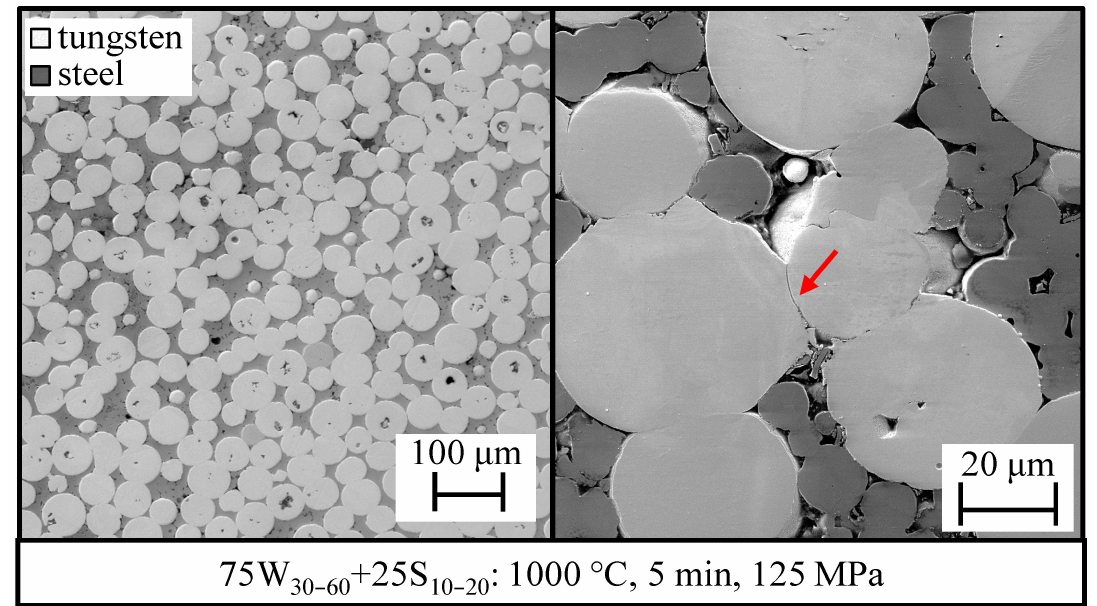
Figure 6. Cross-sectional SEM micrograph of 75 W composite sintered with optimized parameters (1000 ◦ C, 125 MPa, 5